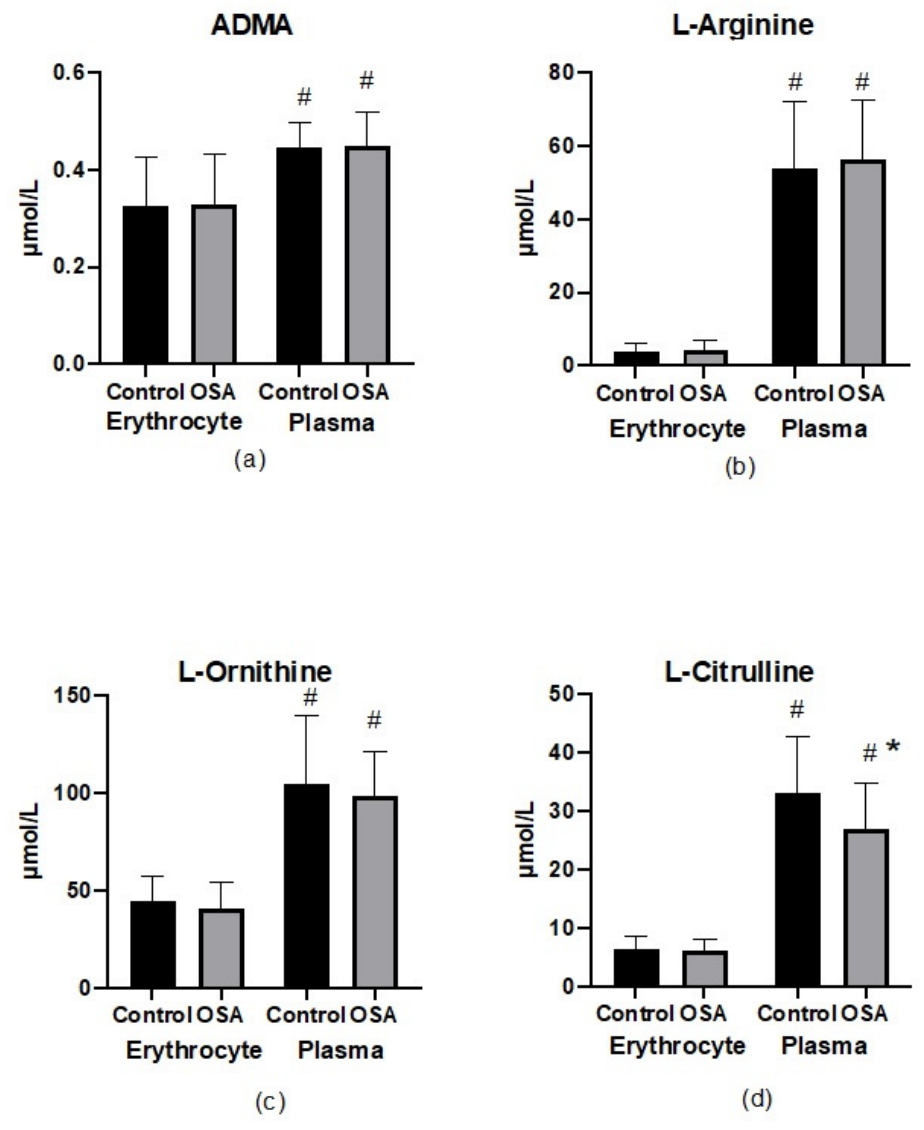
Figure 4. ( a – d ) Nitric oxide metabolite concentrations in different compartments. Bars and whiskers represent the mean ± SD. Abbreviations: ADMA: asymmetric dimethylarginine; OSA: obstructive sleep apnea. * denotes p < 0.05 vs. control in the same compartment; # denotes p < 0.05 between compartments in the same group.